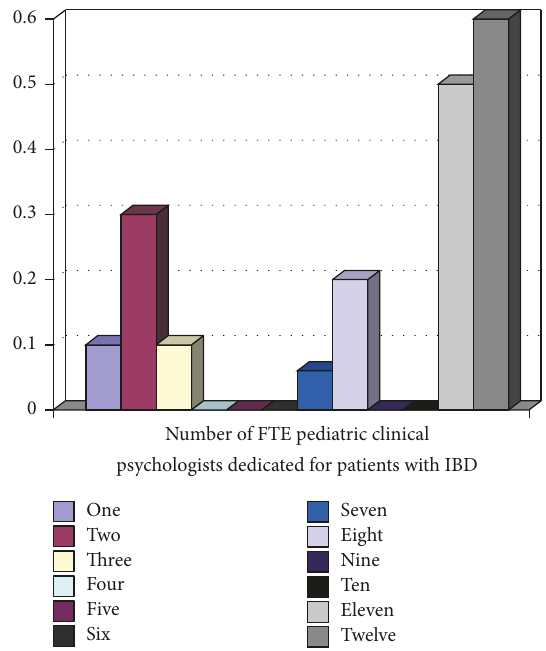
Figure 5: Full-time equivalent (FTE) clinical psychologist/child life workers for children with IBD per centre.